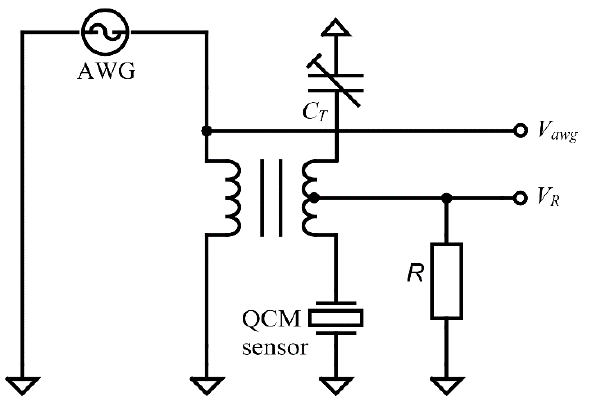
Figure 3. Impedance Analysis method with shunt and stray capacitance